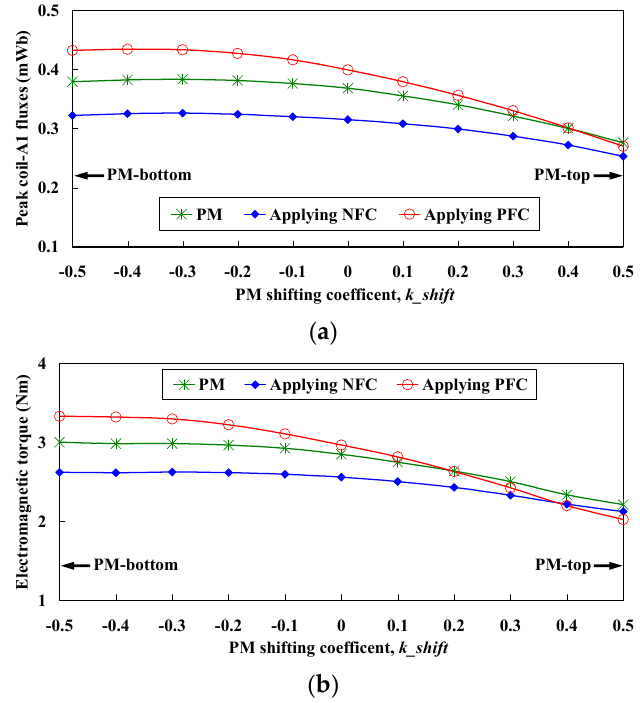
Figure 12. Influences of k shift when NdFeB is adopted (PFC and NFC indicate positive field current and negative field current, respectively). ( a ) Variation of no ‐ load coil ‐ A1 flux; ( b ) Variation of torque values when RMS 98AT per half armature slot is applied.